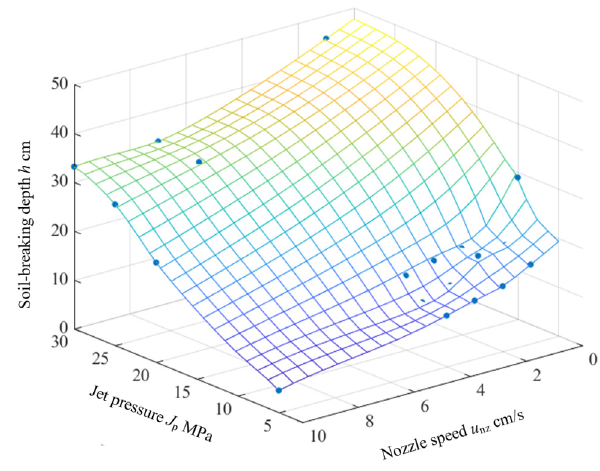
Figure 12. Relationship among soil-breaking depth, jet pressure, and nozzle speed.